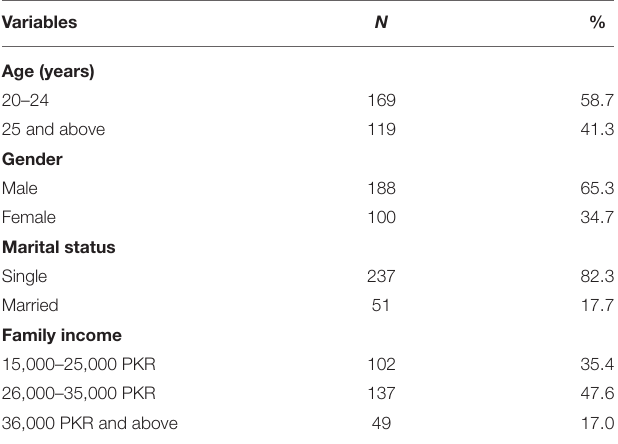
TABLE 1 | Characteristic of the demographic